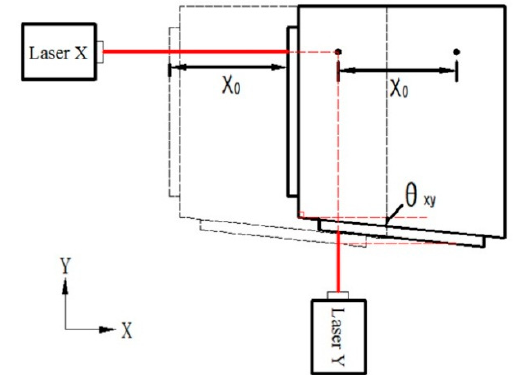
Figure 8. Schematic diagram of X ‐ Y non ‐ orthogonal error.